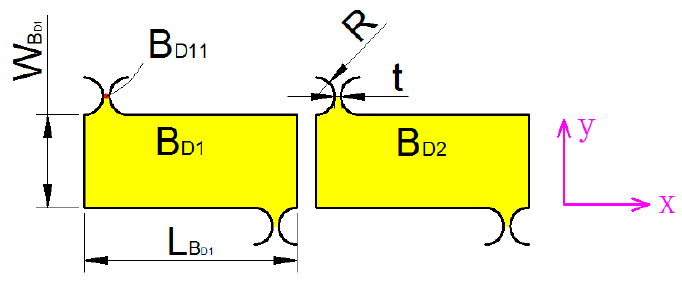
Figure 17. Unit 𝐵 (cid:3005) structure. Figure 17. Unit B D